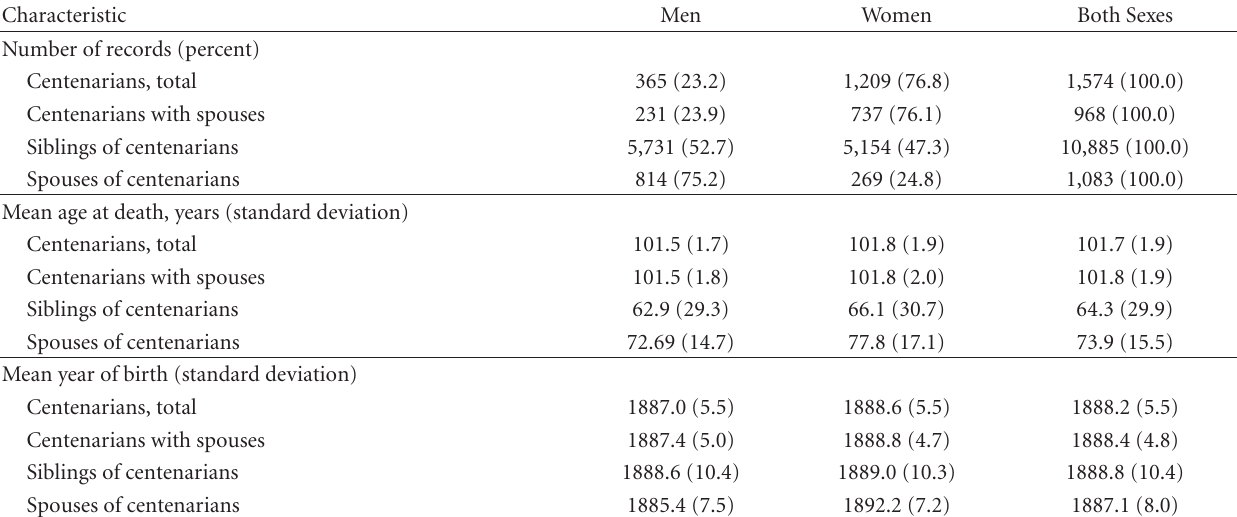
Table 3: Characteristics of centenarians born in 1880–1895 and their siblings and spouses. Values are numbers (percentages) or means (standard